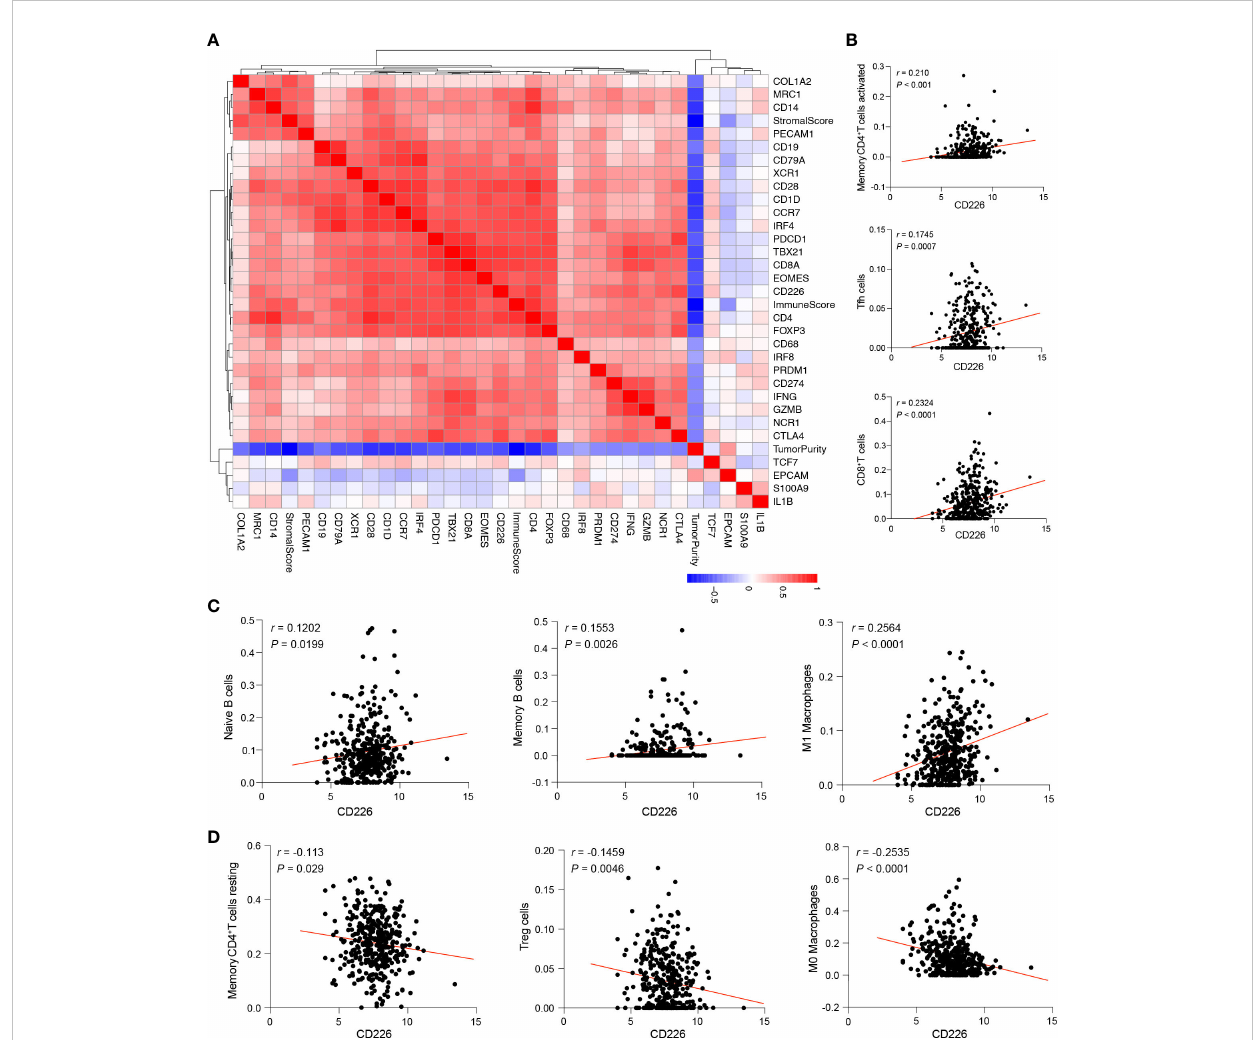
FIGURE 6 Correlation between the expression of CD226 and other cellular components in the TME. (A) . Heatmap showed the correlation of CD226 and tumor purity, stromal score, and immune score, as well as with immune-related genes in TCGA STAD. (B – D) . The dot plot showed the correlation between CD226 and cellular components scored by CIBERSORT and gene sets